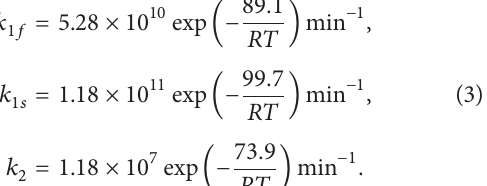
Figure 2: Predicted 3-dimentional changes of xylose concentration at different temperatures by biphasic model. Assumed conditions: 2% (w/v) H 2 SO 4 and 0.8% (w/v) H 3 PO 4 , liquid to solid ratio 3 mL/g, 100–180 ∘ C.